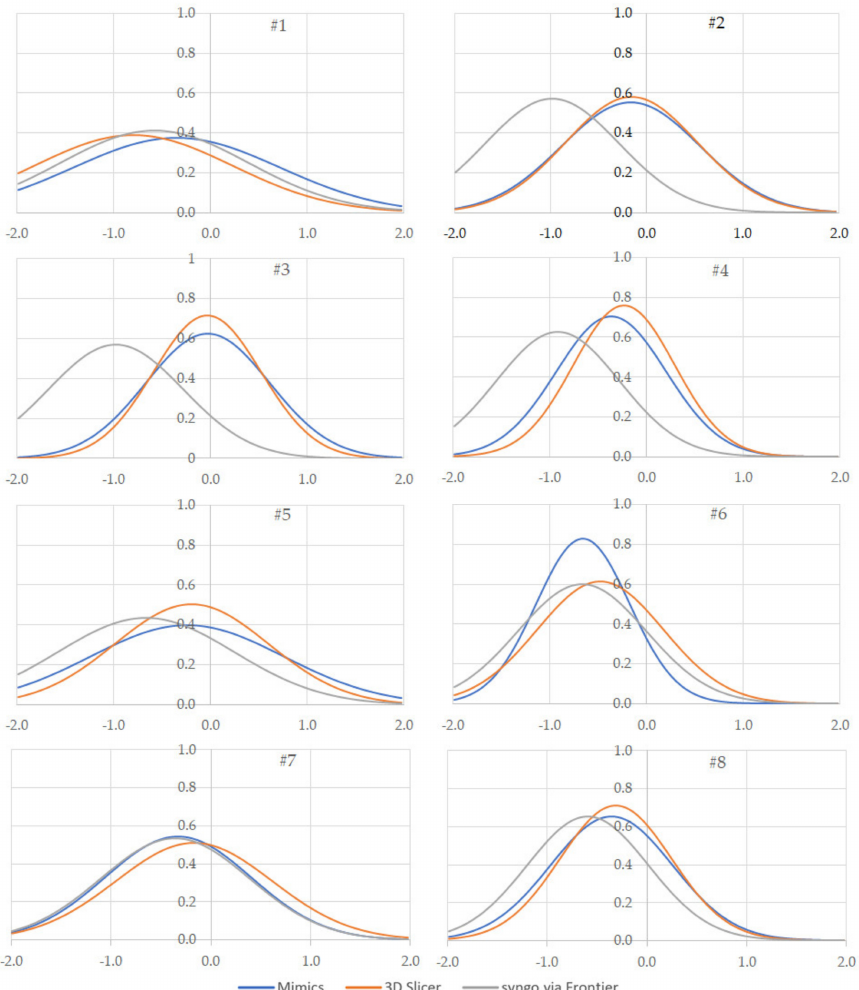
Figure 6. Signed Euclidean distance between the reference ( G_D ) and test ( G_A , G_B , and G_C ) geometries.